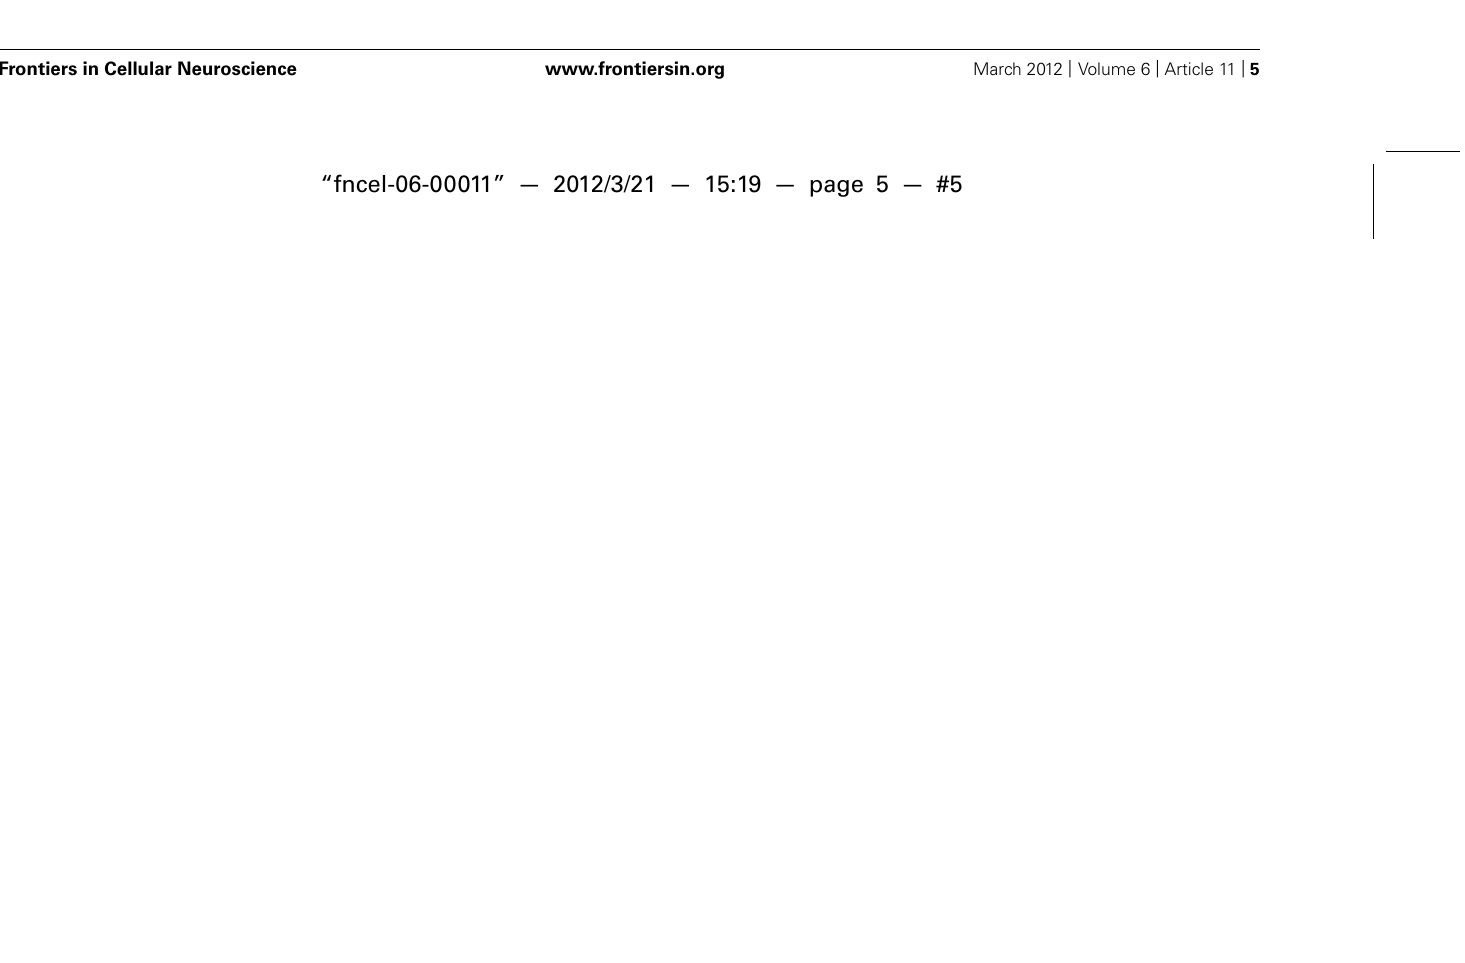
Otx2 (A–D) and the dorsal marker Pax7 (E–H) . Although these panels are taken from regions where most cells express these markers, it should be noted that both markers were heterogeneously expressed throughout the neurospheres in distinct cell clusters, indicating some level of tertiary organization within the spheres. Scale bars: (A–D) 50 μ m, (E–H) 100 μ